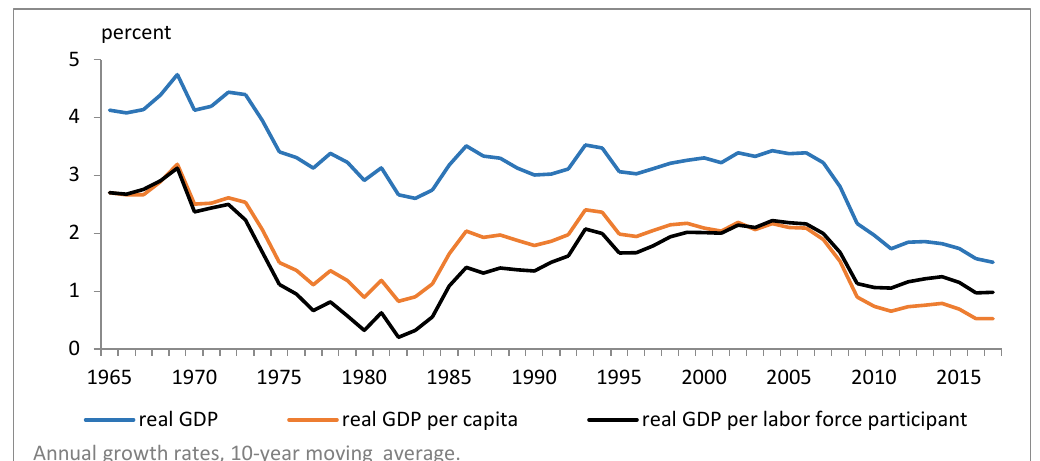
Figure 3: US trend GDP growth